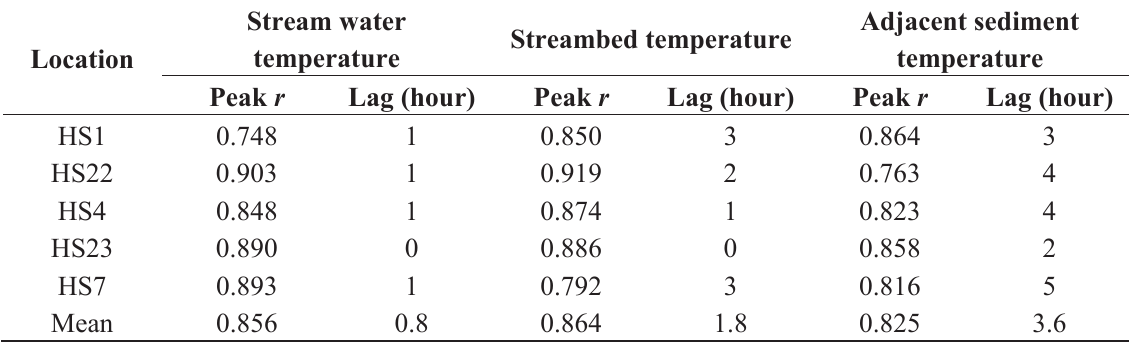
Table 4. Summary of cross-correlation (r) of air temperature with stream water temperature, streambed temperature (depth = 10 cm), and adjacent sediment temperature (depth = 10 cm) at different